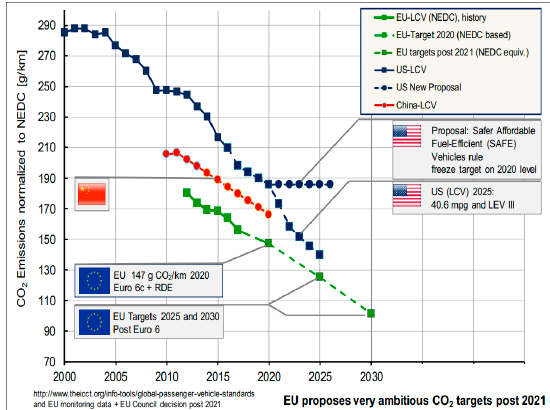
Figure 1. The target and historic CO 2 emissions for light commercial vehicles [4].